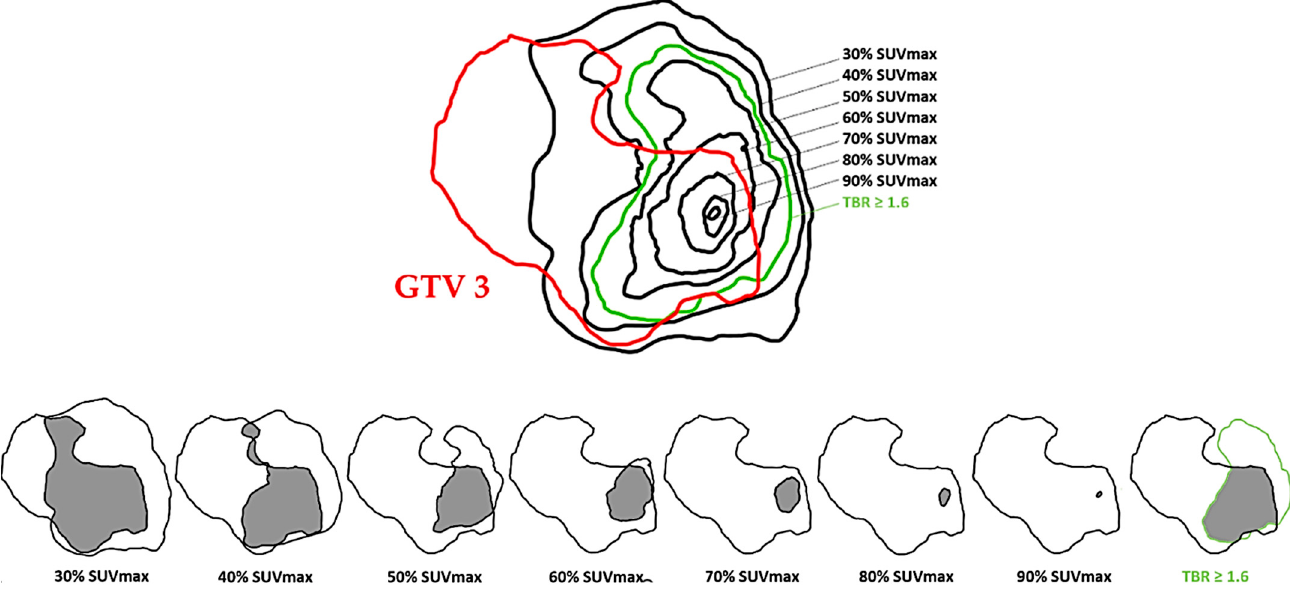
Figure 5. Simplified schematic representation of comparison of tumor volumes on FET PET before RT-CT with GTV 3.